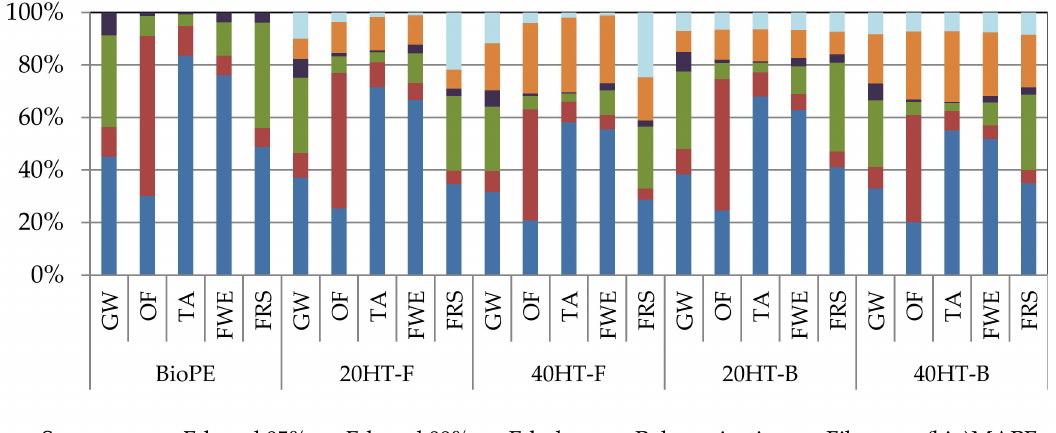
Figure 8. Relative contribution per life cycle stages for the production of fossil PE, BioPE and biocomposites. Results do not include carbon sequestration. Reported per functional unit: 1 kg of